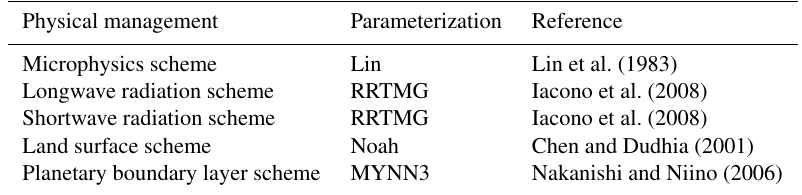
Figure 2. Domain configuration of the WRF model: (a) the range of the four nested domains (d1–d4); (b) the innermost nested domain (d4), within which the black box represents the STAR-CCM+ simulation domain (extracted from © Google Maps 2021). Table 2. Parameterization scheme for the physical processes set up in the WRF